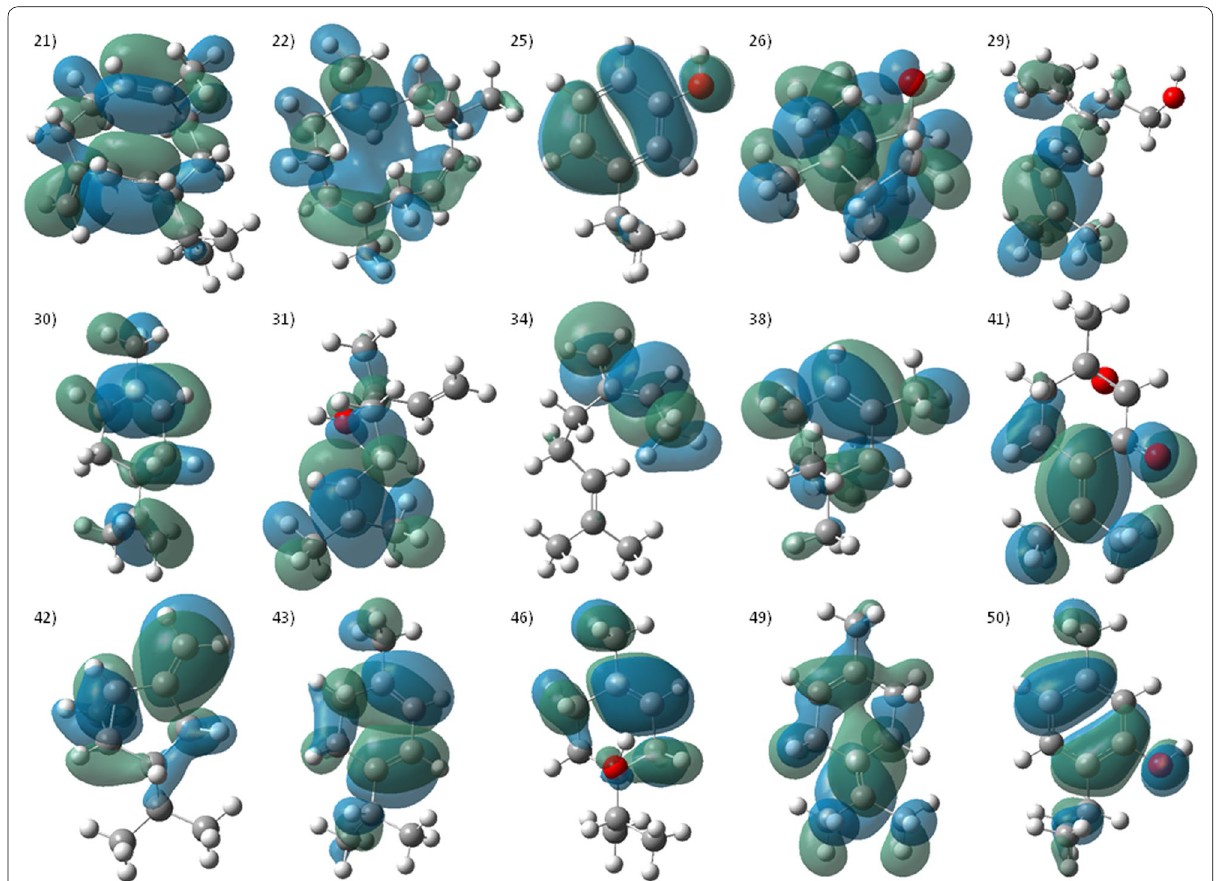
Fig. 5 The contour plots of LUMO orbitals of the most active molecules (conti…). (21) Germacrene‑D, (22) α‑Humulene, (25) 3‑Isopropylphenol, 26) Isoborneol, (29) Lavandullol, (30) Limonene, (31) Linalool, (34) Myrcene, (38) α‑Pinene, (41) Rotundifolone, (42) Sabinene, (43) α‑Terpinene, (46) α‑Terpineol, (48) γ‑Terpineol, (49) Terpinolene, (50)